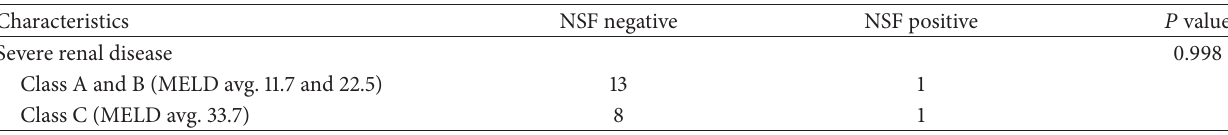
Table 3: In patients with severe renal disease, severe liver disease did not have an association in increasing the risk of NSF. MELD represents the Model for End Stage Liver disease score average.